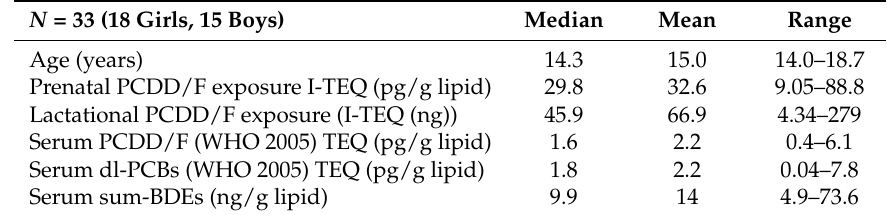
Table 1. Descriptive statistics of the